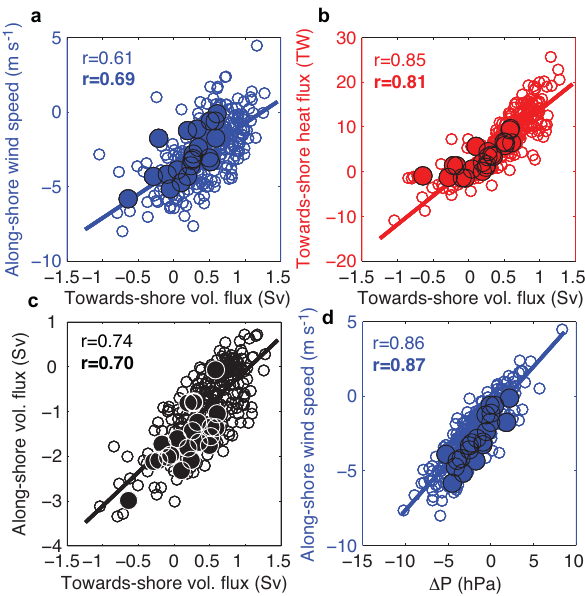
Fig. 8. Correlation plots from ocean reanalysis. (a) Scatter plot of mean monthly volume flux into and out of KTr (yellow line in Fig. 1a) and mean monthly speed of winds crossing Denmark Strait from the north at 66.3 ◦ N. North-flowing waters and wind yield pos- itive values, which means that northerly winds have negative speed while transport into KTr and towards coast is positive. (b) Same as (a) , but with towards-shore volume flux compared against towards- shore heat flux calculated with reference to 0 ◦ C. Heat flow is pos- itive towards north, i.e. when it is directed into KTr and towards the coast. (c) Same as (a) and (b) , but with towards-shore volume flux plotted against the along-shore volume flux, i.e. flow of waters crossing the hydrographic transect shown by white line in Fig. 1a. This volume flux is positive when transport is from west to east. (d) Same as (a) , but with monthly wind speeds plotted against the Denmark Strait atmospheric pressure gradient, 1 P , derived from meteorological stations in Stykkish´olmur and Tasiilaq (see text for details). Open circles and correlation coefficients shown in nor- mal font represent monthly means while data averaged for winters months (December–March) are shown with filled solid circles and bold correlation